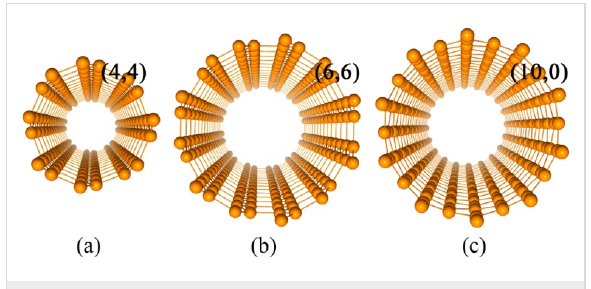
Figure 1: Perspective view of silicon nanotubes (4,4) (a), (6,6) (b) and (10,0)